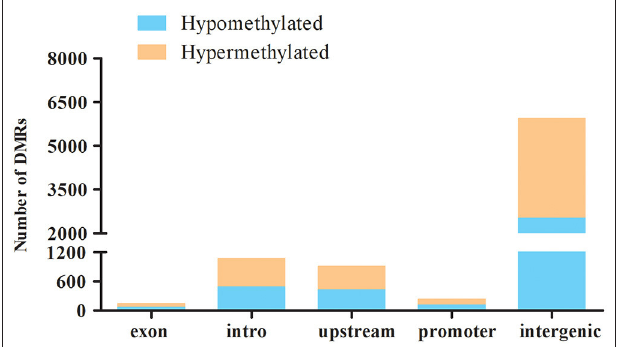
FIGURE 4 | Distribution of the hyper- and hypomethylated DMRs in relation to the genes in the ALV-J-negative as compared with the -positive chicken samples. Distribution of hypermethylation and hypomethylation in each gene elements of ALV-J-positive chicken samples vs. ALV-J-negative chicken samples.